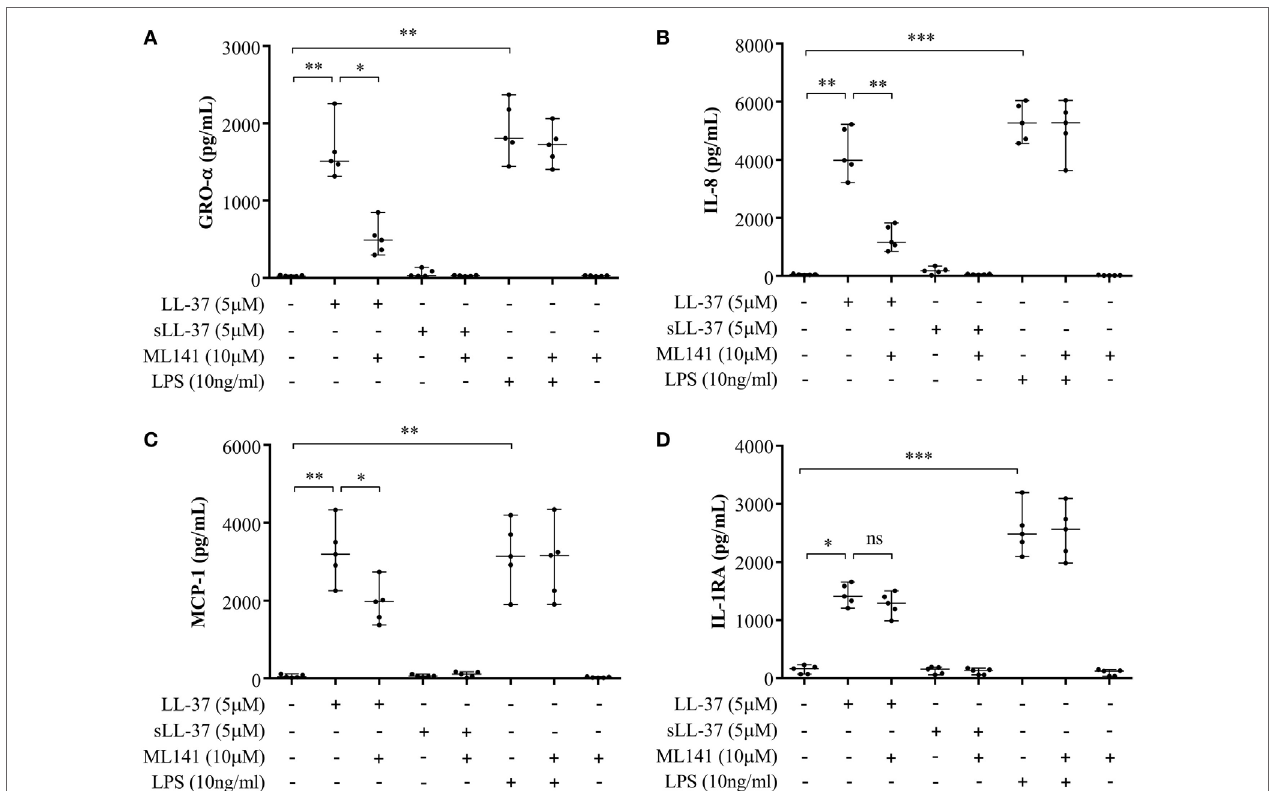
FigUre 4 | Cdc42/Rac1 Rho GTPase controls LL-37-induced chemokine secretion in human peripheral blood-derived mononuclear cells (PBMCs). Human PBMCs were pre-incubated with Cdc42/Rac1 inhibitor ML141 (10 µM) for 1 h prior to stimulation with either LL-37 (5 µM), sLL-37 (5 µM), or lipopolysaccharide (10 ng/ml). Tissue culture supernatants were monitored by ELISA for the production of chemokines (a) GRO- α , (B) IL-8, and (c) monocyte chemotactic protein-1 after 24 h, and (D) the anti-inflammatory cytokine IL-1RA after 48 h. Results shown are from five independent experiments ( n = 5) using PBMCs isolated from independent donors, each dot represents an independent donor and the line shown is the median for each condition. Kruskal–Wallis analysis of variance with Dunn’s multiple comparison test was used for statistical analyses (* p < 0.05, ** p < 0.005, *** p <